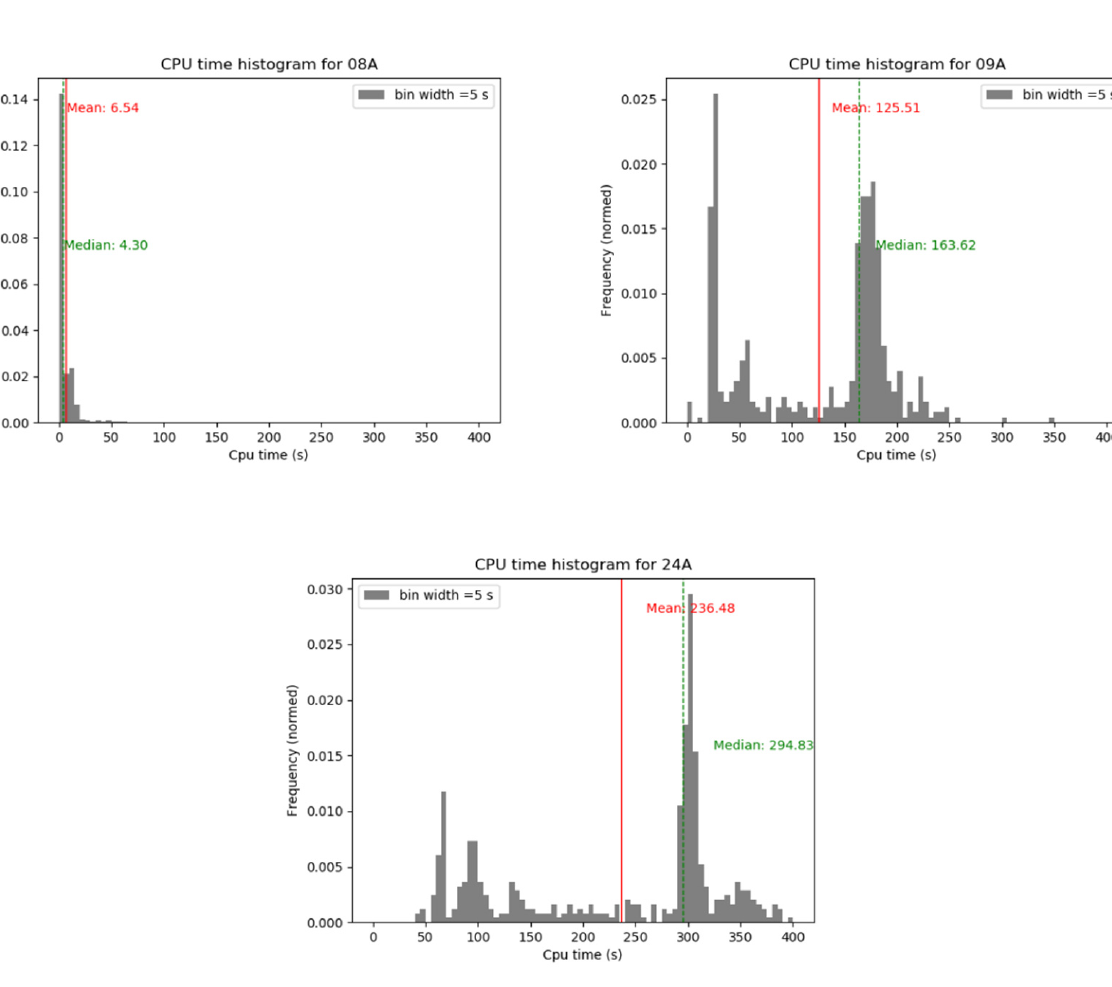
Figure 11. Histogram of the CPU time for all the analyzed nodalizations.